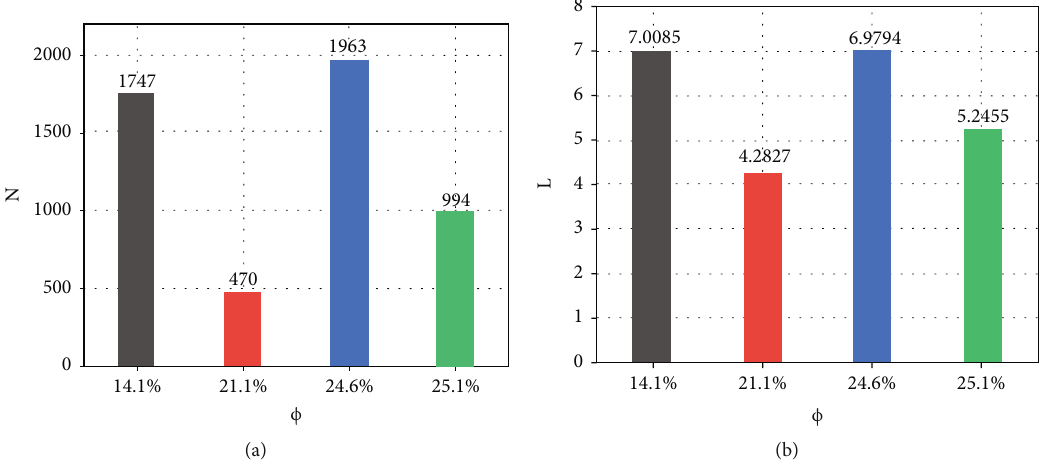
Figure 5: (a) The network magnitude. (b) The average path length ( L ).